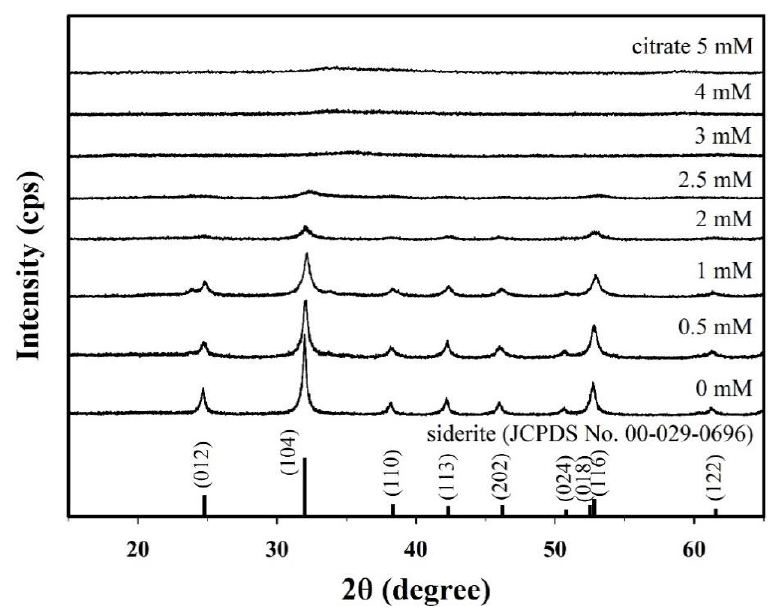
Figure 1. X-ray di ff raction (XRD) patterns for the citrate / FeCO 3 nanocomposites (CF-NCs) synthesized Figure 1. X-ray diffraction (XRD) patterns for the citrate/FeCO 3 nanocomposites (CF-NCs) in the presence of di ff erent citrate concentrations (0–5 synthesized in the presence of different citrate concentrations (0–5 mM).